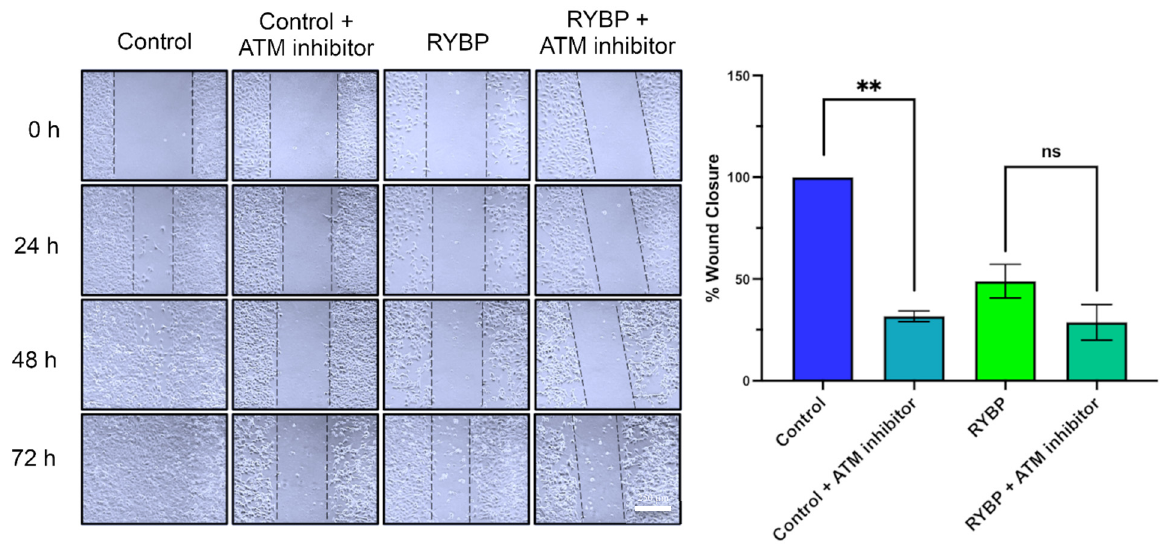
Figure 4. Effects of RYBP and ATM inhibition on U2OS cell migration. Left; wound closure assays of control cells ± ATM inhibitor and RYBP-expressing cells ± ATM inhibitor. Right; quantification of % wound closure at 72-h time-point. RYBP alone significantly reduced migration of U2OS cells and further addition of ATM inhibitor in RYBP-expressing cells did not further reduce cell migration. ** p < 0.1 in comparison to control (one-way ANOVA). ns; non ‐ significant.